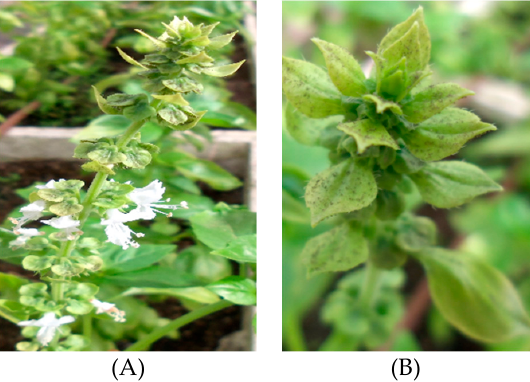
Figure 6. The appearance of downy mildew in flowering basil plants in the field. Seeds were harvested from such plants to examine seed infection and transmission of P. belbahrii . ( A )—A flowering basil plant infected with downy mildew. ( B )—A close-up photo of the apex, showing heavy sporulation of P. belbahrii.